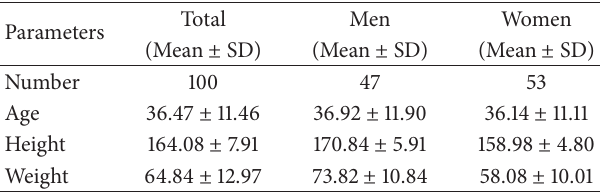
Table 1: Subject demographics (cm;